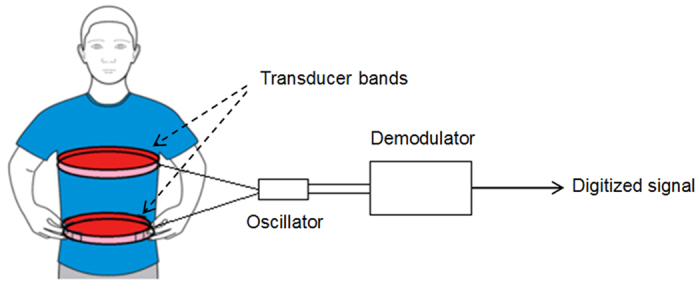
Schematic of RIP method.